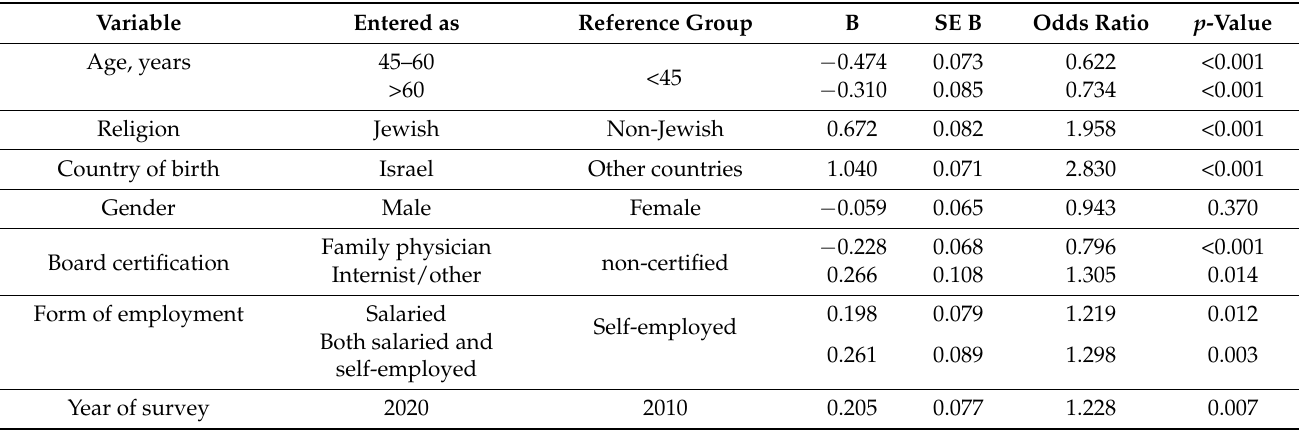
Table 4. Logistic regression of physician perceptions of nurses’ shared responsibility for quality-of- care, to a very great